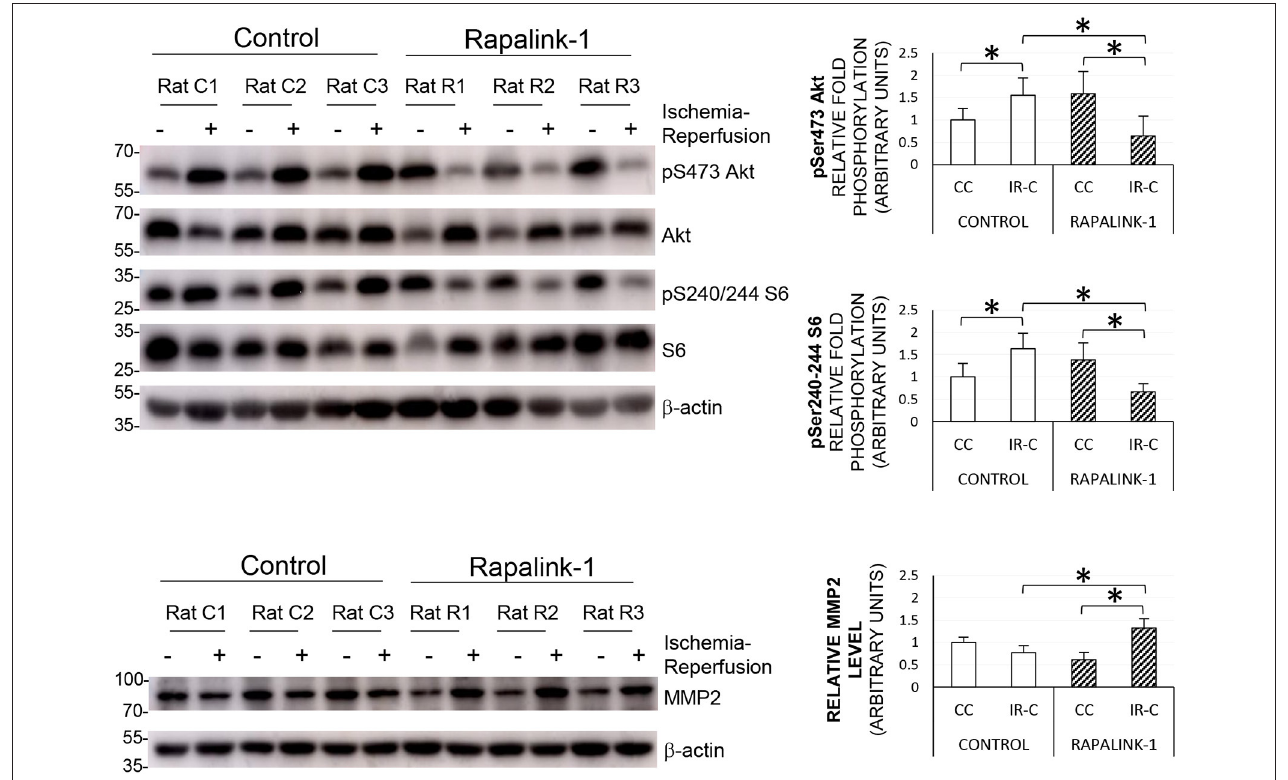
FIGURE 4 | The representative Western blots of pS6, pAkt, and MMP2, and their quantification after 1h of MCAO and 2h of reperfusion. ANOVA followed by multiple comparisons with the Bonferroni correction was used for the quantification of protein. The Phosphorylation of Akt at Ser473 and the phosphorylation of S6 at Ser240/244 were increased during ischemia–reperfusion that indicates the increased activity of mTORC2 and mTORC1, respectively. The treatment with Rapalink-1 resulted in a more than 50% decrease in the phosphorylation of both Akt and S6 in the IR-C when compared with the control rats, which suggests that Rapalink-1 inhibited both mTORC1 and mTORC2 in this experiment. The increased protein level of MMP2 with Rapalink-1 treatment in the IR-C suggests that Rapalink-1 could aggravate blood–brain barrier (BBB) disruption in the ischemic-reperfused area. CC, contralateral cortex; IR-C, ischemic-reperfused cortex; Control, MCAO/reperfusion group; Rapalink-1, MCAO/reperfusion + Rapalink-1 group. n = 6–9. * p < 0.05. Values are means ±